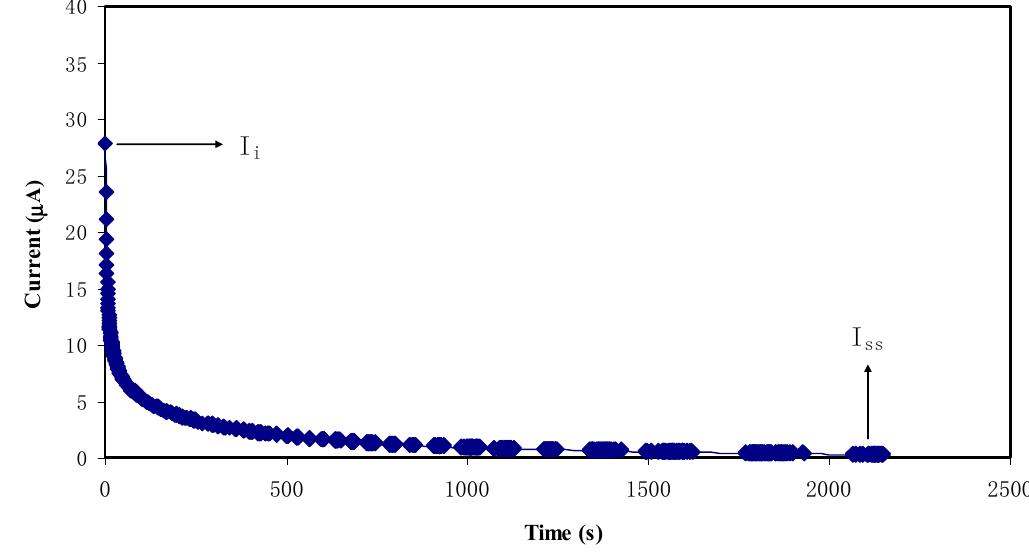
Figure 8. Polarization current versus time for the CSDPB4 blend electrolyte film.